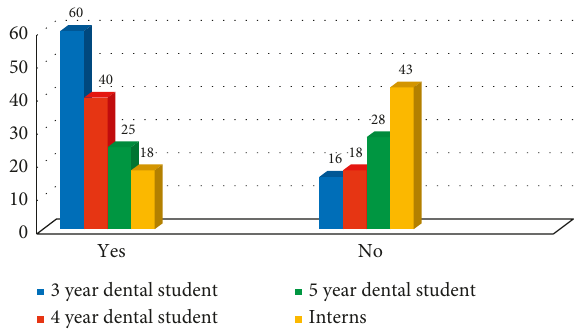
Figure 8: Awareness of participants toward radiation hazard signs 24.52 with P 0 . 01). ( χ 2 (cid:31) ≤